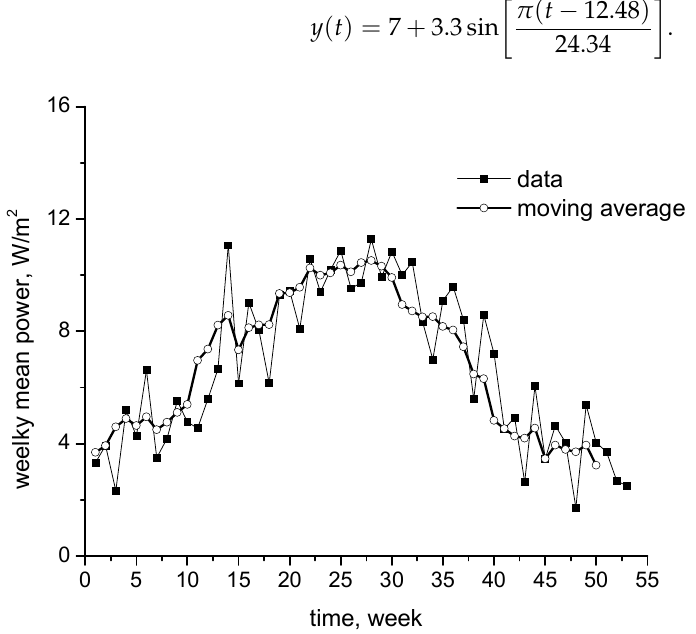
Figure 5. The moving average ( n = 6) applied to the weekly average data. This last model is consistent with time series as revealed by the graph in Figure 6. The coefficient of determination computed with the same program was R 2 = 0.90.